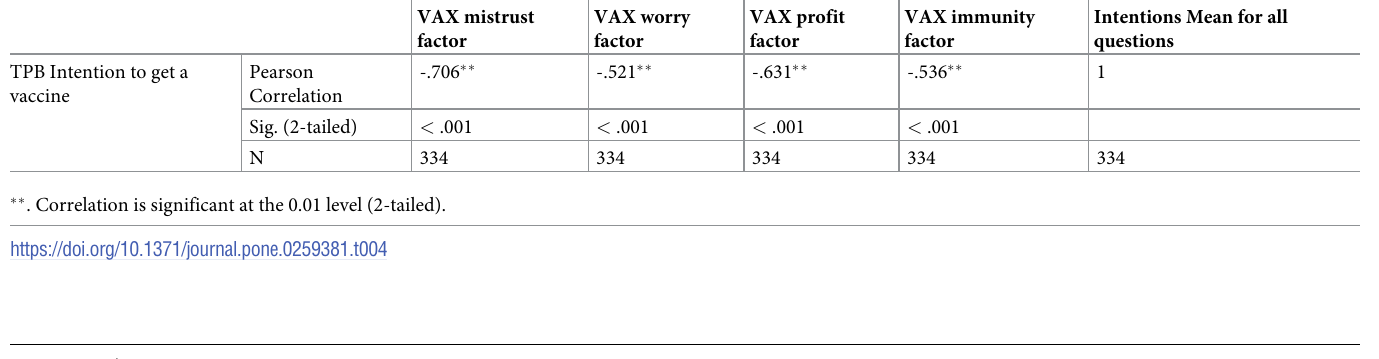
ables (See Table 5). The regression model explained 71% of the variance in intentions (F